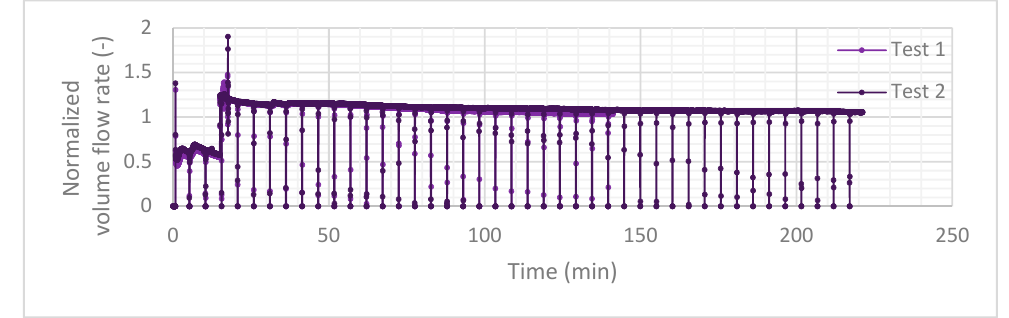
Figure A9. Normalized input power to the air compressor unit at the thermostatic temperature of 0 °C.